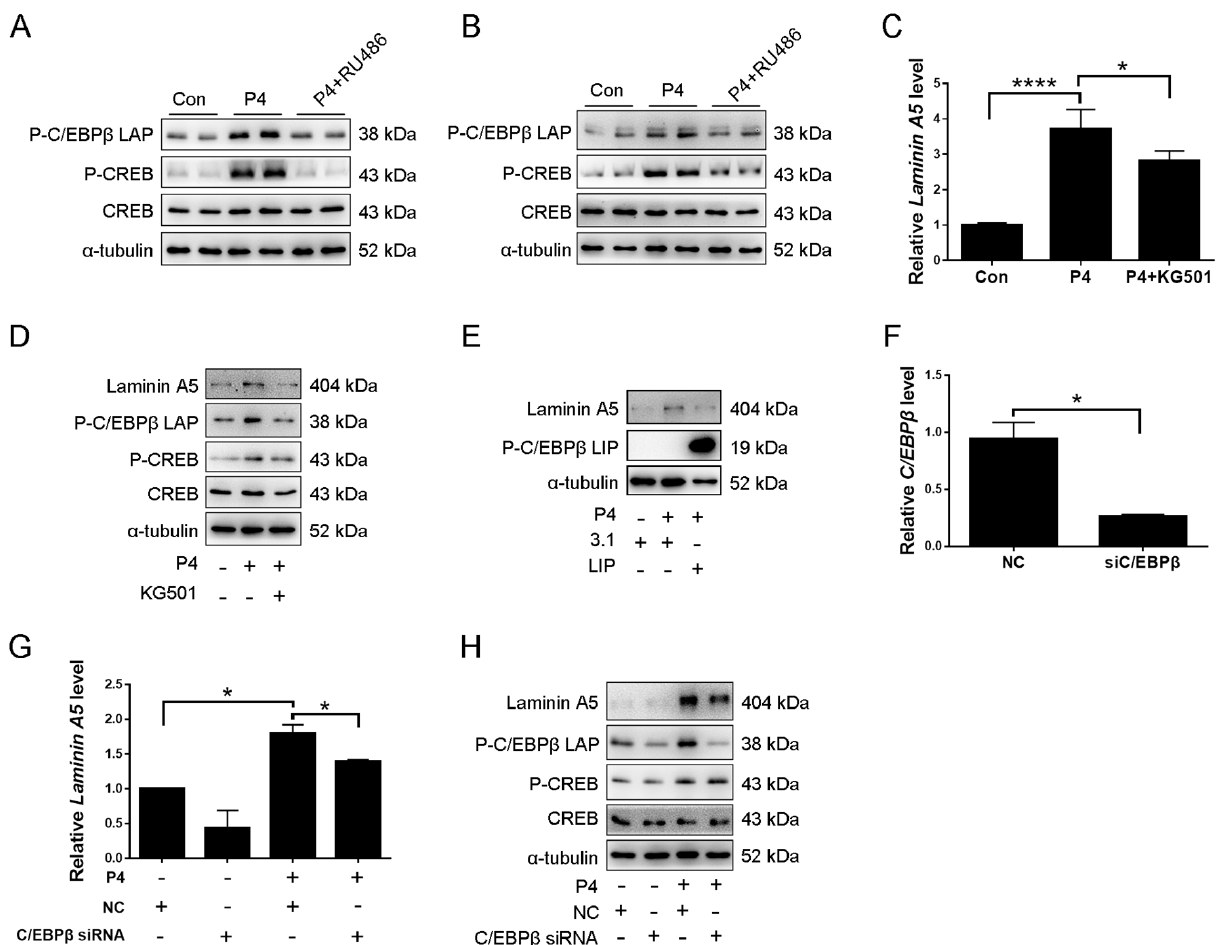
Figure 6. CREB-C/EBP β mediates progesterone induction on laminin A5 expression. ( A ) Western blot analysis of effects of RU486 on progesterone induction on p-CREB and p-C/EBP β -LAP expression in ovariectomized mouse uteri. ( B ) Western blot analysis of effects of RU486 on progesterone induction on p-CREB and p-C/EBP β -LAP expression in cultured stromal cells. ( C ) RT-qPCR analysis on effects of CREB inhibitor KG-501 on progesterone induction of Laminin A5 expression in stromal cells. ( D ) Western blot analysis on effects of KG-501 on progesterone induction of laminin A5, p-CREB, and p-C/EBP β -LAP expression. ( E ) Western blot analysis on the effect of C/EBP β -LIP overexpression on progesterone induction of laminin A5 expression. ( F ) RT-qPCR analysis of C/EBP β mRNA levels after stromal cells were treated with C/EBP β siRNA. ( G ) RT-qPCR analysis of effects of C/EBP β siRNA on progesterone induction of Laminin A5 expression. ( H ) Western blot analysis of effects of C/EBP β siRNA on progesterone induction of laminin A5, p-CREB, p-C/EBP β -LAP expression. Bars represent mean ± SD (* p -value < 0.05, **** p -value < 0.0001). 3.1, empty pcDNA 3.1 (+) vector; LIP, C/EBP β -LIP overexpression